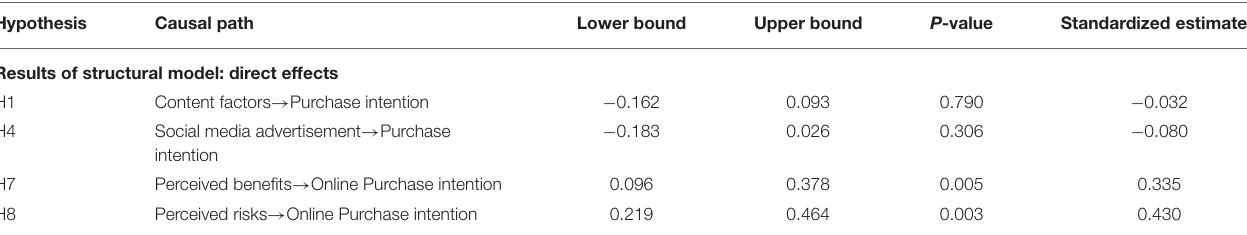
TABLE 6 | Direct findings of the SEM.